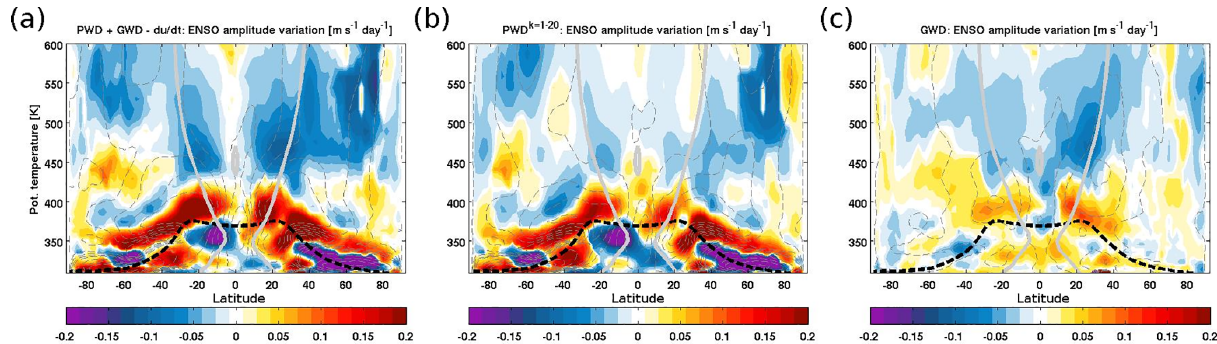
Figure 10. Zonal mean distribution of the ENSO impact on monthly mean net resolved wave drag (a) , planetary wave drag (PW) (d) , and gravity wave drag (c) derived from ERA-I reanalysis. The amplitude variations (term b 2 × SD ( MEI ) ) attributed to the ENSO events is calculated by projecting the regression fits onto the ENSO basis functions for the 1979–2013 period. Black dashed horizontal line indicates the climatological tropopause from ERA-I. Zonal mean climatologies are overplotted as dashed grey lines. The thick grey line indicates the zero line zonal mean